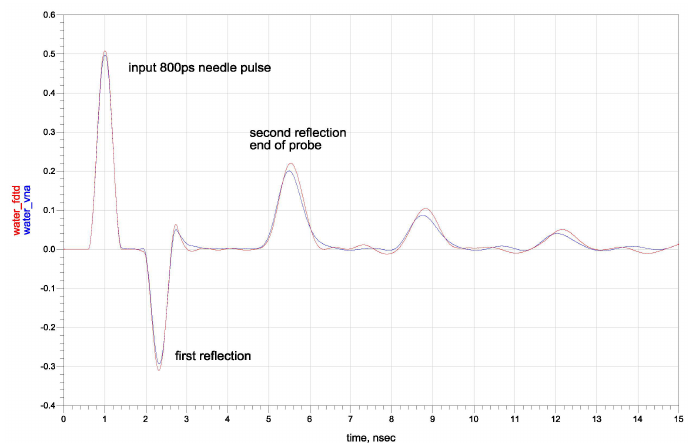
Figure 6. The comparison in the time domain of the results obtained with VNA S11 measurements of distilled water (the blue curve) and the S11 simulated (the red curve) for the five-rod probe inserted into material with Debye parameters: ε 8 = 5, ε s = 80, σ = 50 µ S ¨ m ´ 1 , τ = 8 ps.